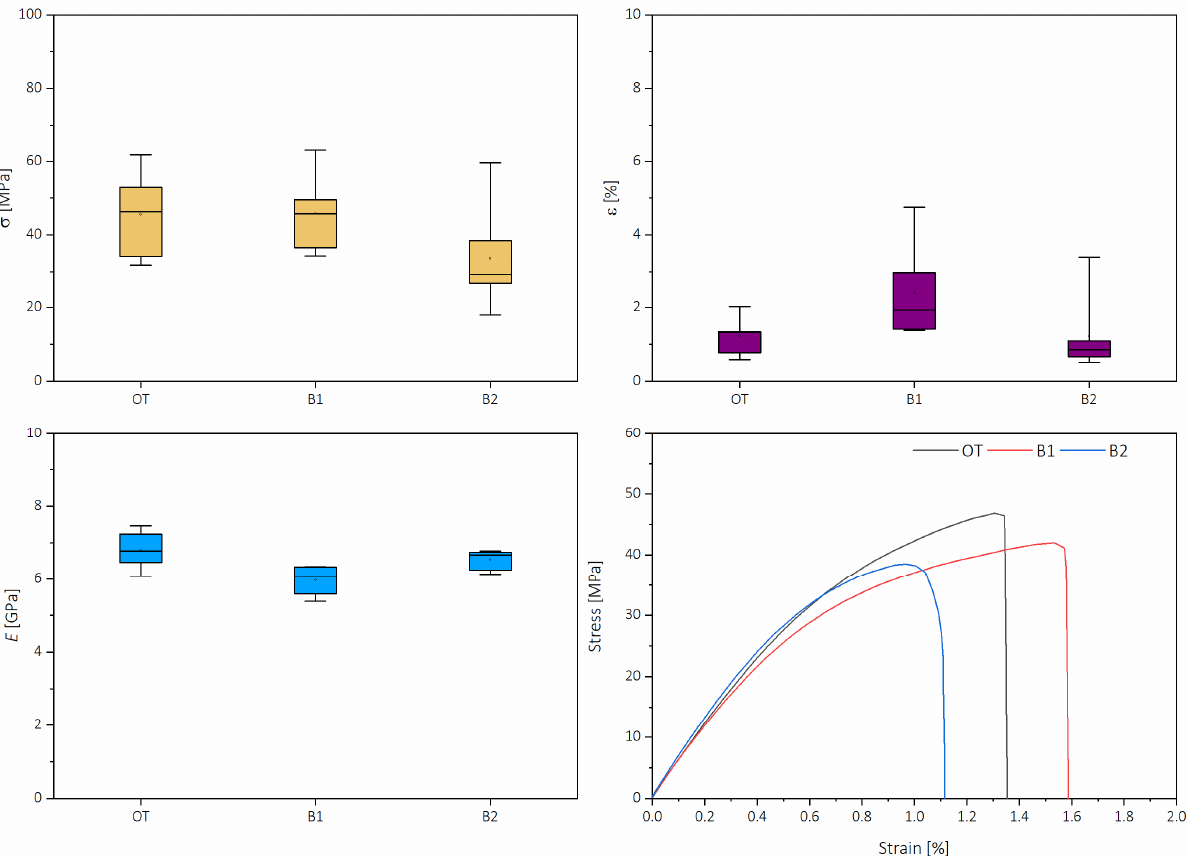
Figure 7. Modulus of elasticity ( E ), ultimate tensile strength ( σ ), strain at rupture ( ε ) and stress vs. strain diagrams (closest diagram to mean values).